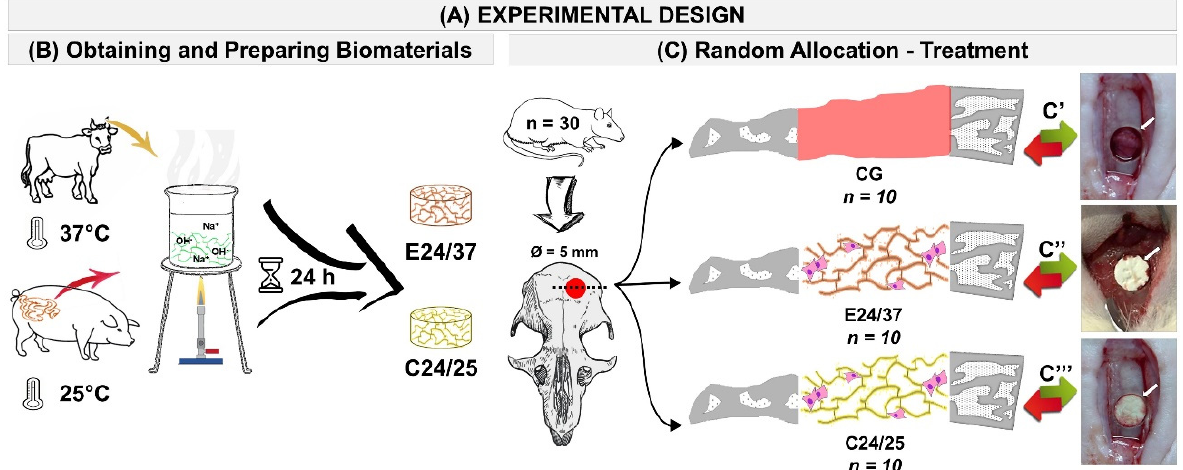
Figure 7. Schematic drawing of the experimental design ( A ). Preparation and application of biomaterials. Hydrolysis bovine auricular cartilage at 37 °C for 24 h and hydrolysis porcine intestinal serosa 24 h at 25 °C ( B ). Random Allocation — Treatment: Inclusion criteria: 30 male rats, Rattus norvegicus , Wistar, 112 days old and average weight of 360 g were randomly separated into three groups: Control Group (CG, n = 10), calvarial defects filled with blood clot (without scaffold); E24/37 ( n = 10), bovine elastin matrix filled calvarial defects hydrolysed for 24 h at 37 °C and C24/25 ( n = 10), porcine collagen matrix filled calvarial defects hydrolyzed for 24 h at 25 °C ( C ). Surgical procedure: C ′ — bone defect without scaffold; C ″ -bone defect filled E24/37 and C ′′′ - bone defect filled C24/25.